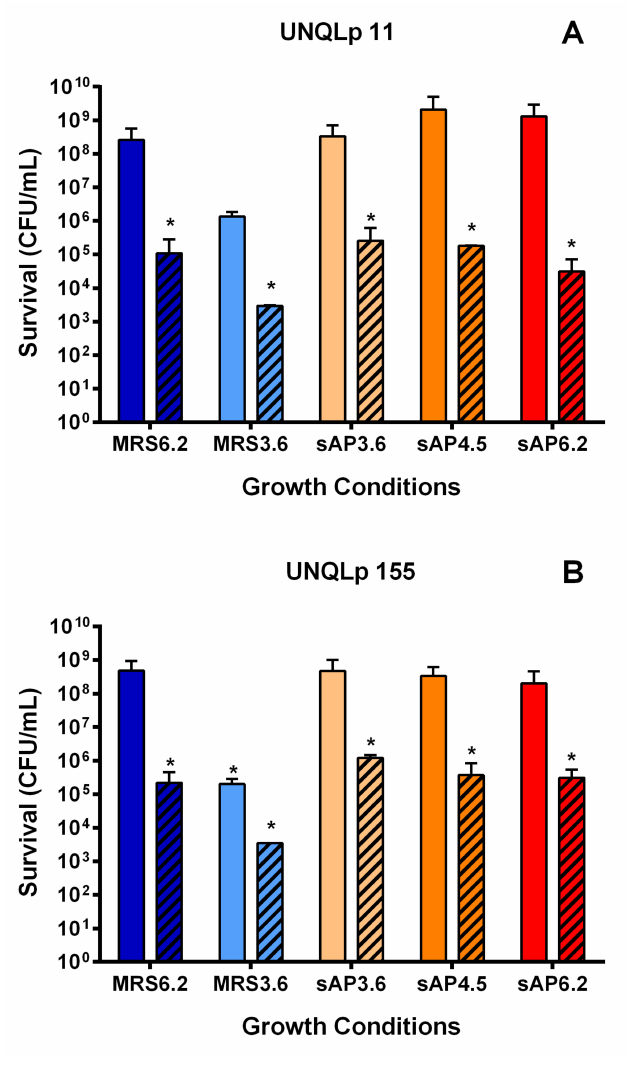
Figure 2. Bacterial viability of UNQLp 11 ( A ) and UNQLp 155 ( B ) strains, after 24 h (smooth bars) and 7 days (striped bars) of incubation in synthetic wine (ethanol 13% v/v , pH 3.5) at 21 ◦ C. Cultures were grown in sAP (supplemented with yeast extract, salts and Tween), at different pH (3.6, 4.5 and 6.2), or in MRS broth (pH 3.6 and 6.2) as control, until stationary phase. The statistical analysis was done using ANOVA and Dunnett’s multiple comparisons test with de control (MRS pH 6.2). Differences were considered significant when p < 0.05